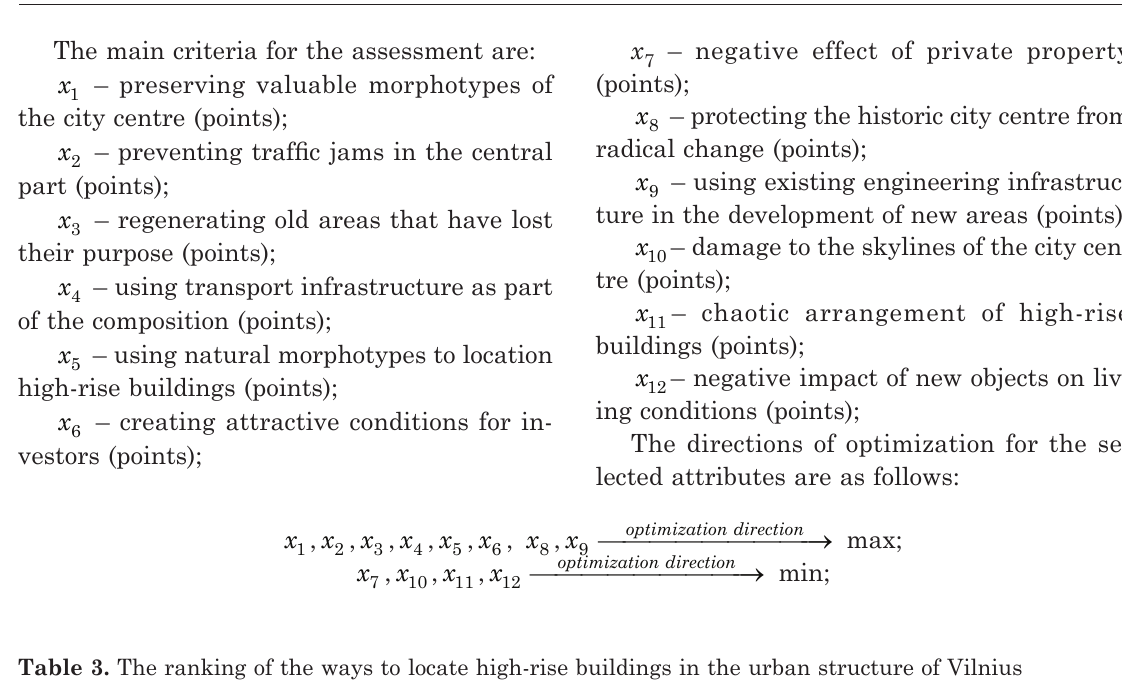
table 3. the ranking of the ways to locate high-rise buildings in the urban structure of Vilnius